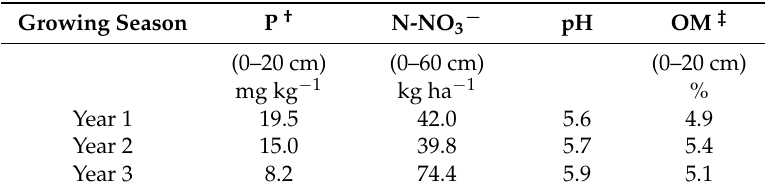
Table 1. Soil characteristics during planting of maize for three growing seasons at Balcarce,